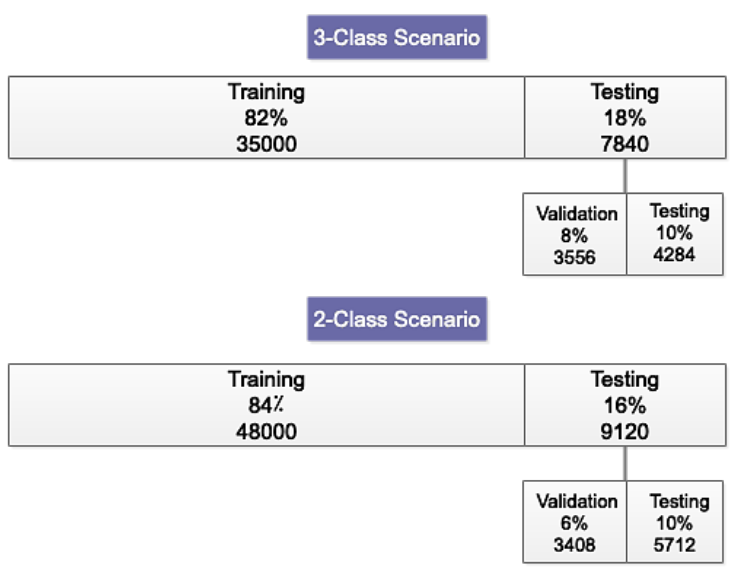
Figure 6. EEG data allocation in the proposed method for two-class and three-class scenario.